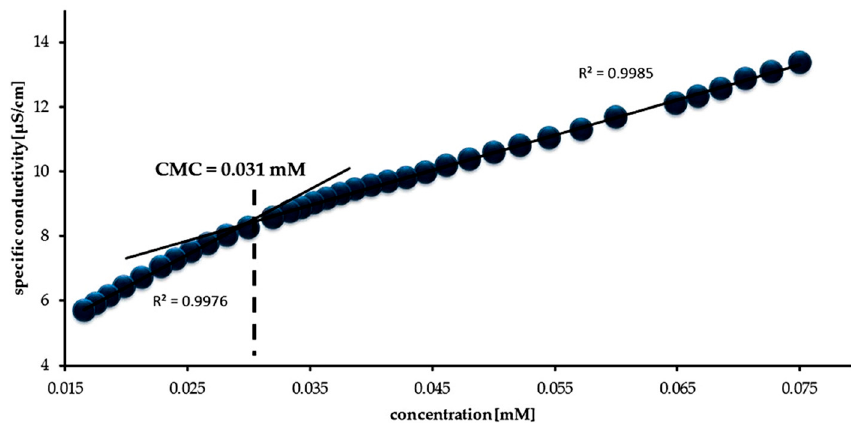
Figure 3. Specific conductivity versus surfactant concentration in water for 16-O-16.